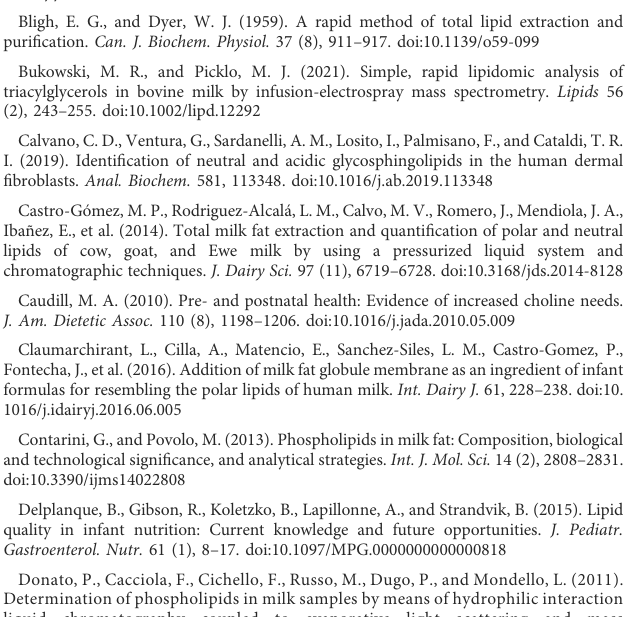
SUPPLEMENTARY TABLE S1 List of identi fi ed phospholipids in human milk detected by UPLC-Q- TOF-MS. SUPPLEMENTARY TABLE S2 List of identi fi ed glycerides and free fatty acids in human milk detected by